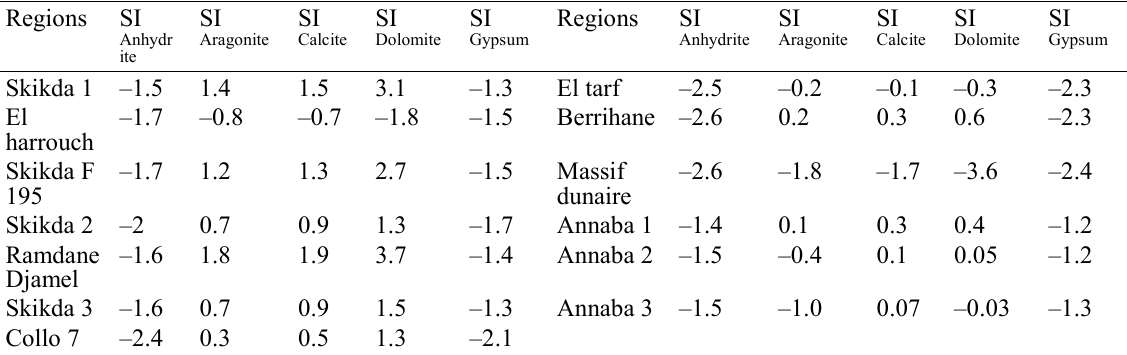
Table 4 Saturation indices values in Gasmi (2009), Aoun Sebaiti (2010), Ghrieb (2011), Djabri et al. (2013) and Habes Sameh (2013).